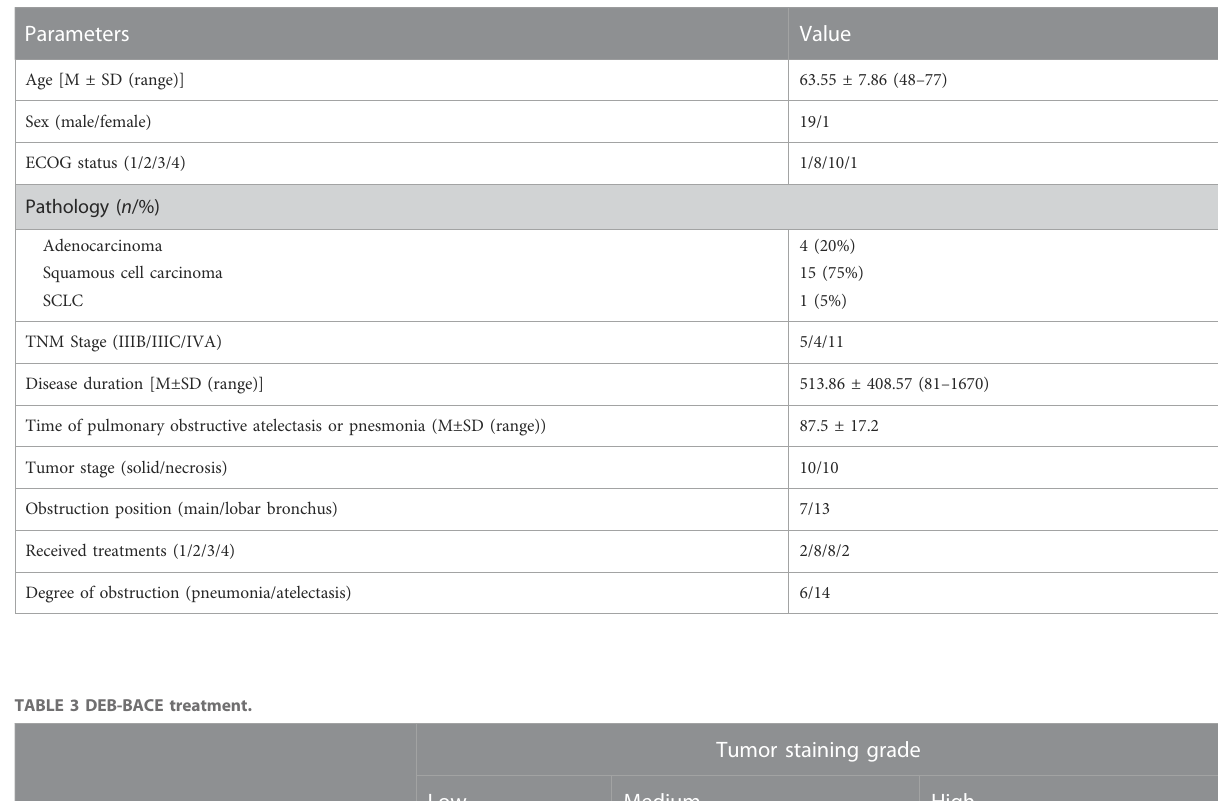
TABLE 2 Baseline characteristics of the enrolled patients.